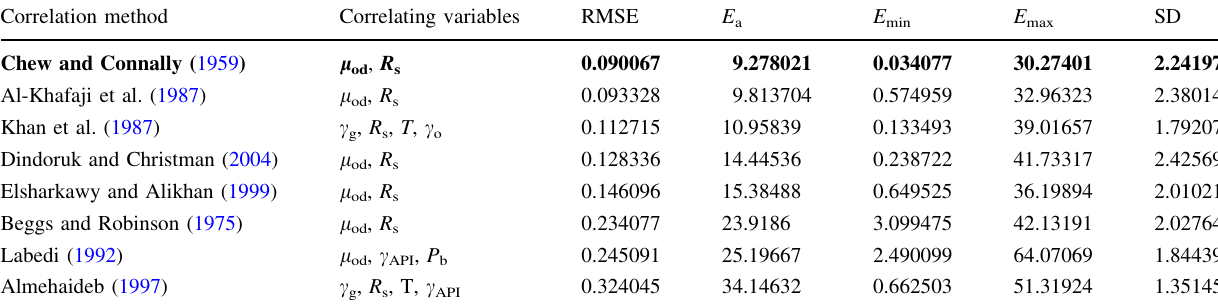
Table 8 Performance of l ob empirical correlations